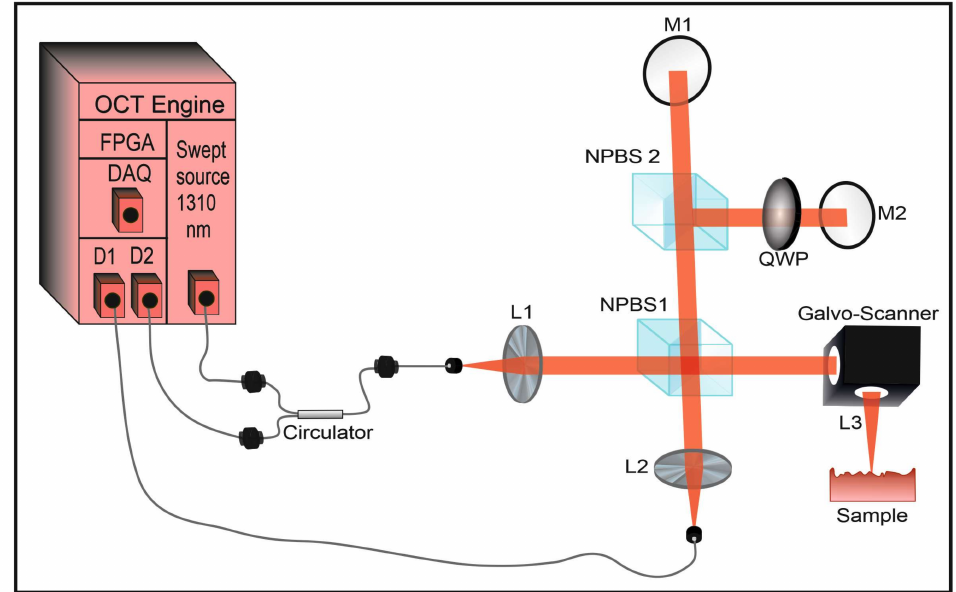
Figure 1. Schematic of the cross-polarized optical coherence tomography system. The abbreviated components of the system are optical coherence tomography (OCT), field-programmable gate array (FPGA), data acquisition card (DAQ), diode (D), lens (L), non-polarizing beam splitter (NPBS), quarter-wave plate (QWP), mirror